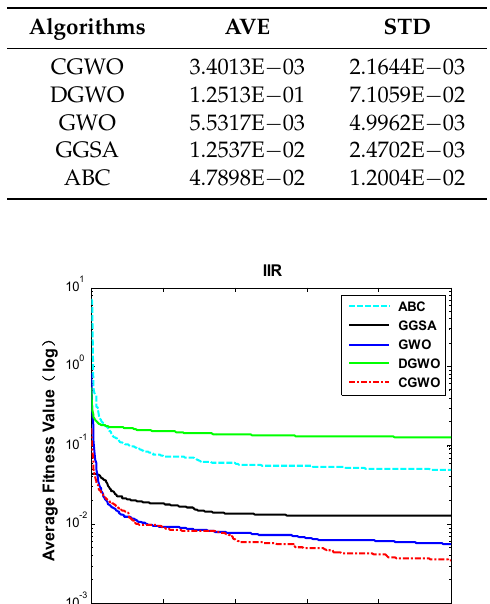
Table 14. The average f p θ q value (AVE) and the standard deviation (STD).